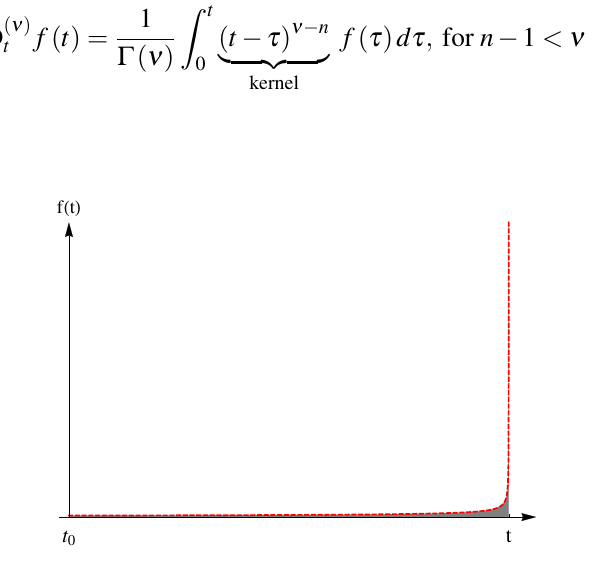
Fig. 4 Plot of the kernel of integrand in RL and C